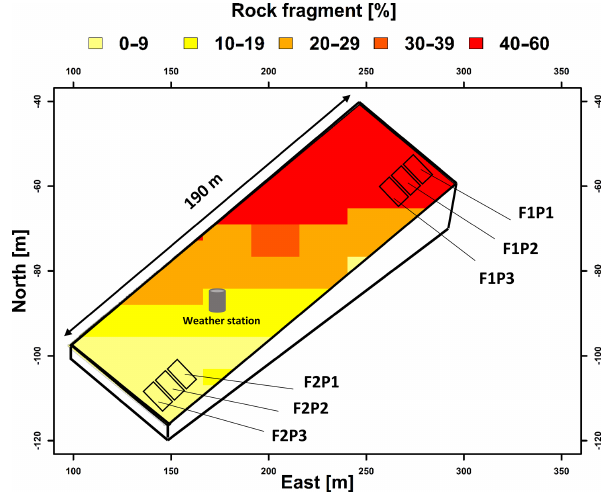
Figure 1. Description of the location of field experiment and setup of water treatments in the stony soil (F1) and silty soil (F2). P1– P3 are the sheltered, rainfed, and irrigated plots. Rock fragments are gravels with weathered